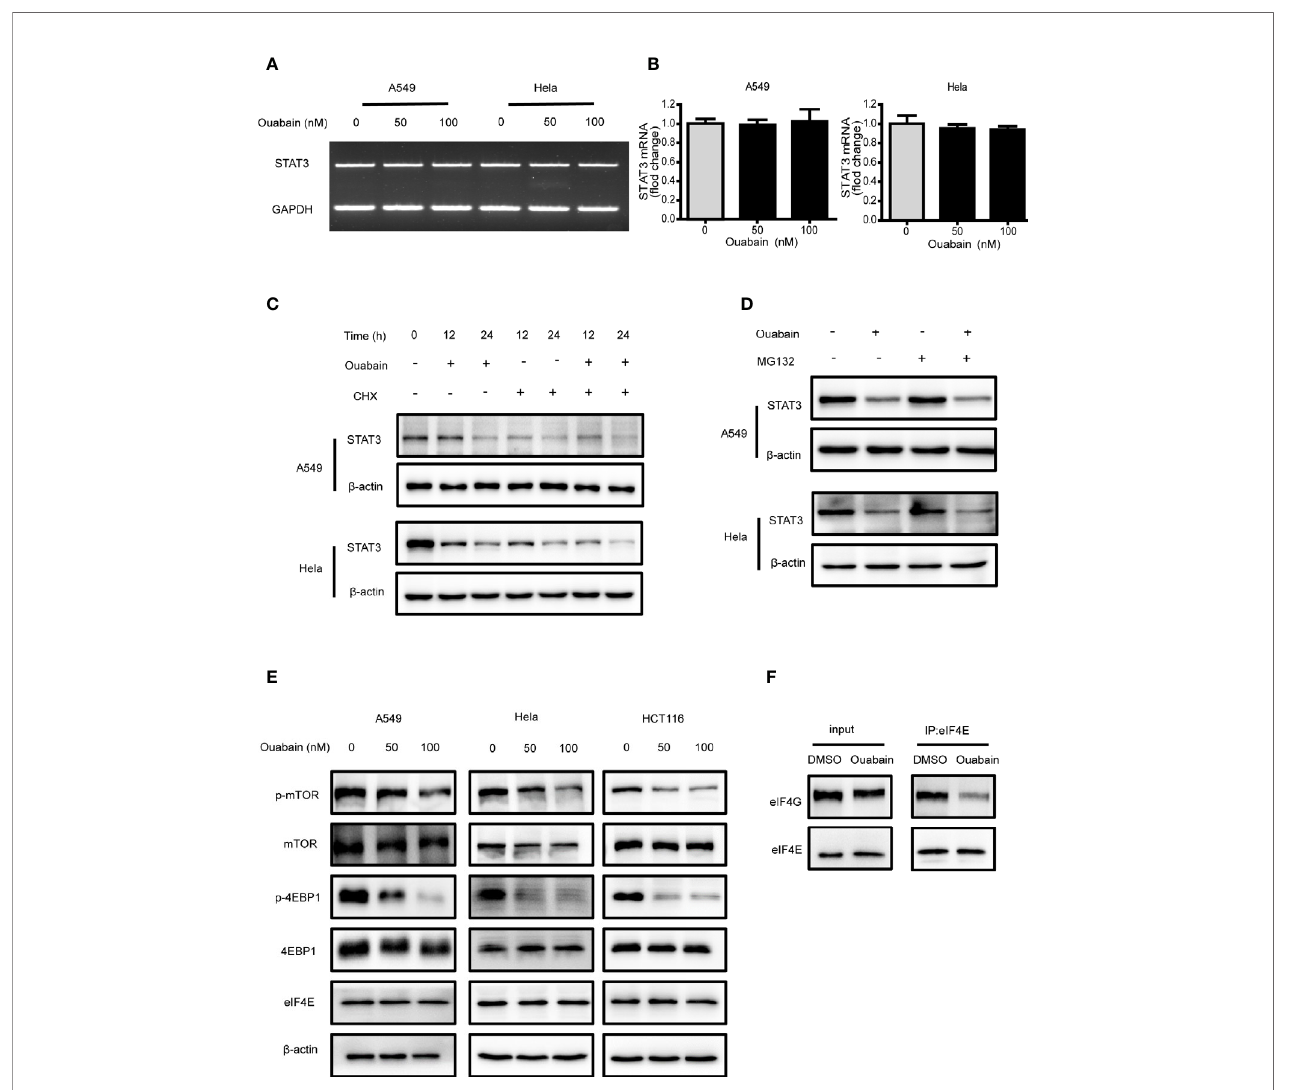
FIGURE 6 | Ouabain inhibited the protein synthesis of STAT3. (A, B) A549 and Hela cells were exposed to ouabain for 24 hours, and STAT3 mRNA expression was determined by PCR. (C, D) A549 and Hela cells were treated with vehicle or ouabain in the presence or absence of cycloheximide (CHX) (C) or MG132 (D) , the expressions of STAT3 were analyzed by Western blotting. (E) A549, Hela and HCT116 cells were treated with different concentrations of ouabain for 24 hours, the expressions of p-mTOR, mTOR, p-4EBP1, 4EBP1 and eIF4E were analyzed by Western blotting. (F) Immunoprecipitation analysis of eIF4E and eIF4G in Hela cells treated with or without